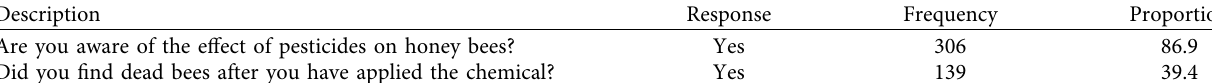
Table 12: Awareness of farmers and their observations on the efect of pesticides on bees.